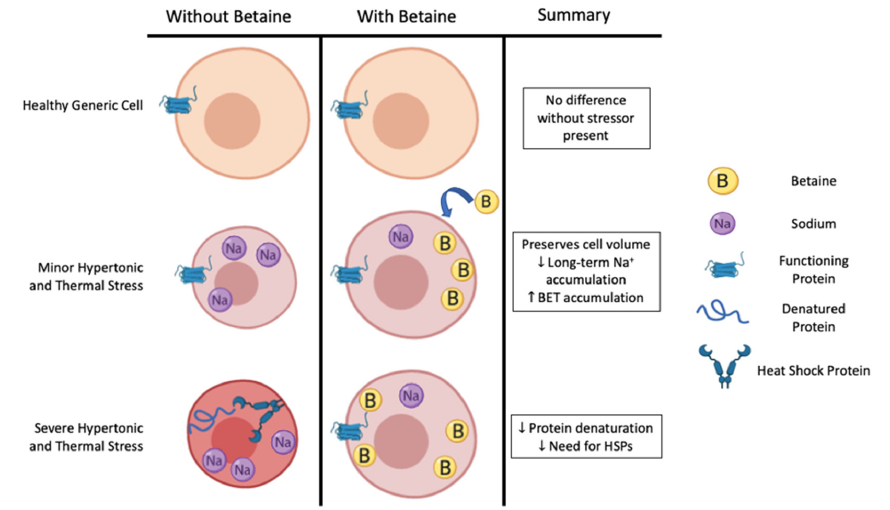
Figure 1. Betaine’s potential role in preserving cell function during increasing severities of hypertonic and thermal stress, as evidenced by data from cell culture models. BET: betaine, HSPs: heat shock proteins, Na + : sodium.